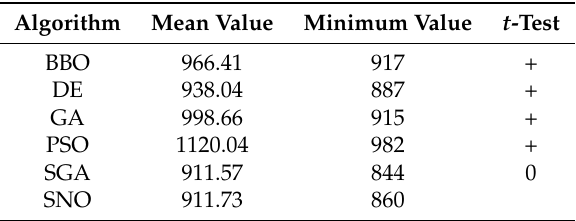
Table 2. Results of the